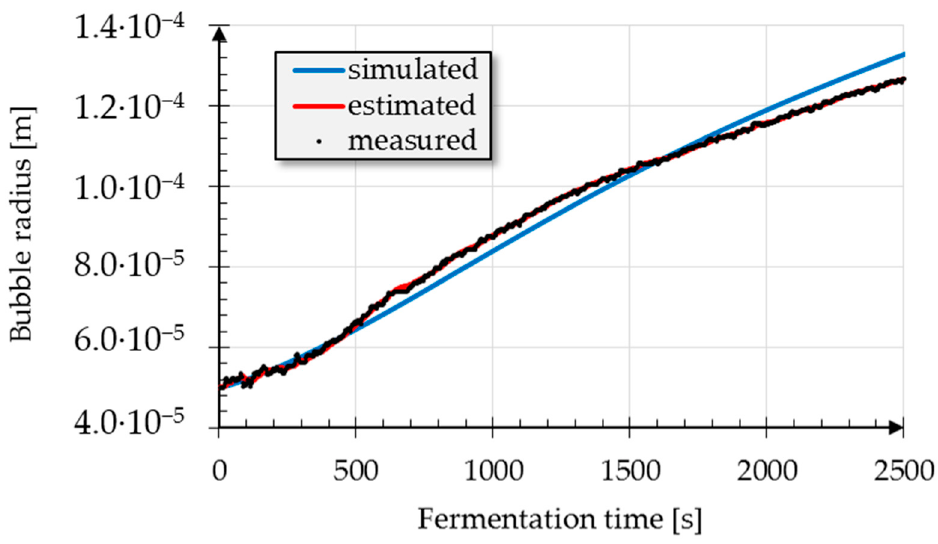
Figure 1. Bubble radii calculated by the imaging system compared to the values estimated by the extended Kalman filter as well as simulated values.